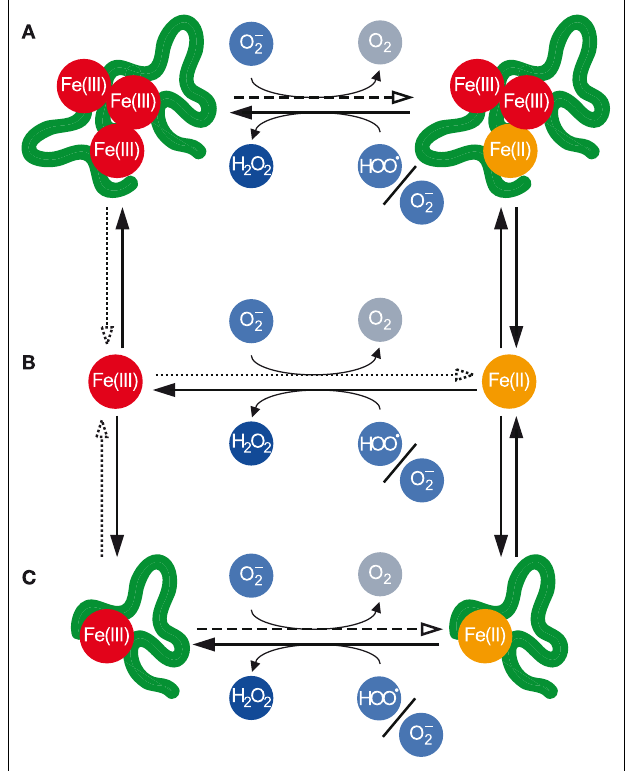
FIGURE 2 |Transformations between various pools of Fe as mediated by O −∗ . (A) Polynuclear complexes, which contain multiple Fe atoms and 2 may also contain other inorganic and organic ligands. (B) Mononuclear inorganic complexes. (C) Mononuclear organic complexes. Fe(III) in all pools may be reduced by the O − anion to Fe(II), while Fe(II) in all pools may 2 be oxidized to Fe(III) primarily by HOO • , but also indirectly by O − .The dotted 2 arrows denote the dissociative reduction (DR) pathway, while the